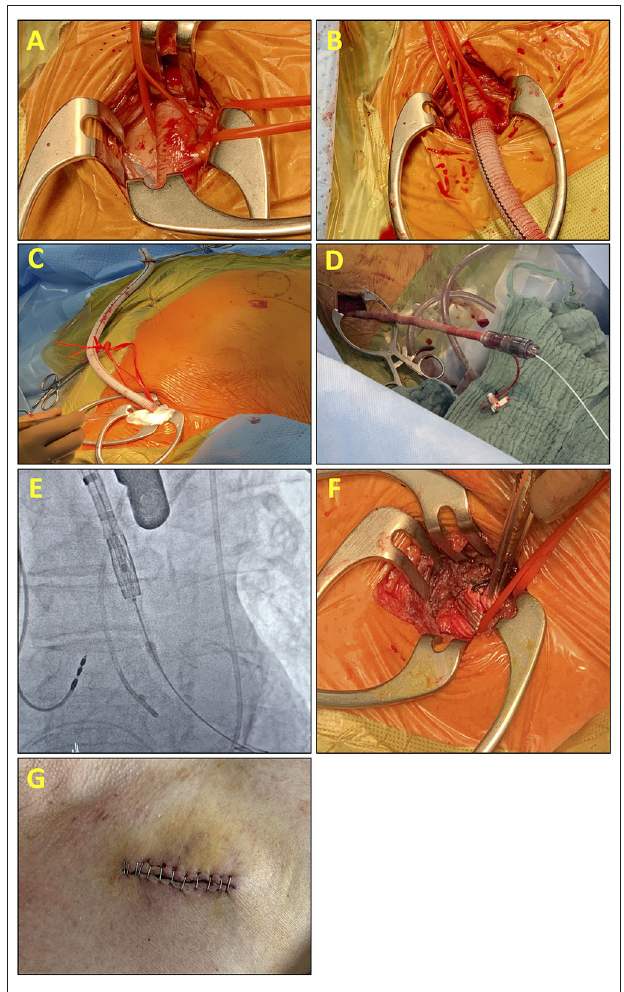
FIGURE 1 | Intraoperative pictures and fluoroscopic images explain the steps of the transaxillary (Tax) end-to-side prosthetic conduit for vessel access. (A) Preparation of the axillary artery with (B) end-to-side anastomosis of an 8-mm Dacron graft to the axillary artery. (C) Final position and length of the Dacron graft before the introduction of the eSheath. (D) eSheath is placed through the Dacron graft into the ascending aorta. (E) Fluoroscopic-guided advancement of the valve system through the subclavian artery with the Confida wire in the left ventricle. After valve implantation, the e-Sheath is retracted. (F) Postinterventional situs: Cut and clipped Dacron graft. (G) The wound is closed in a standard fashion with or without a drainage tube according to the preferences of the